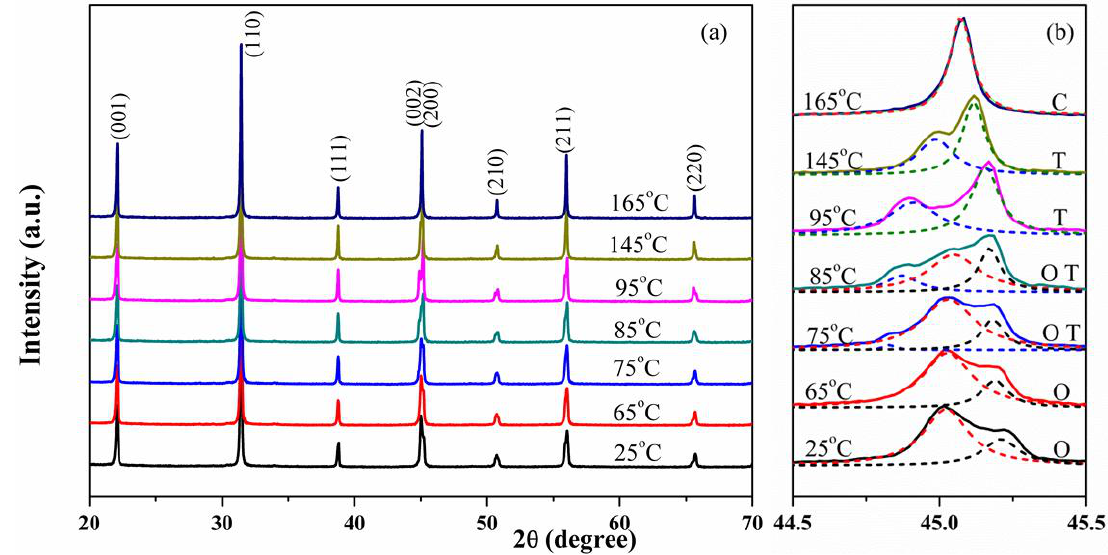
reflection peaks c (left) and (200) (right) splitting peaks of T phase. T T fitted peak of C c